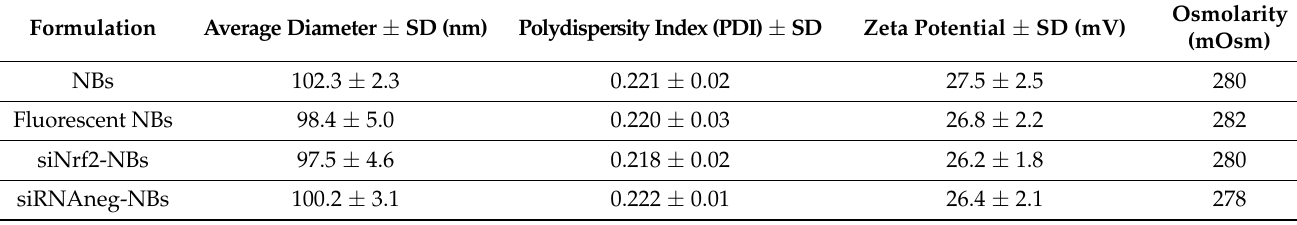
Table 1. Physicochemical parameters of the siRNA-loaded NBs.